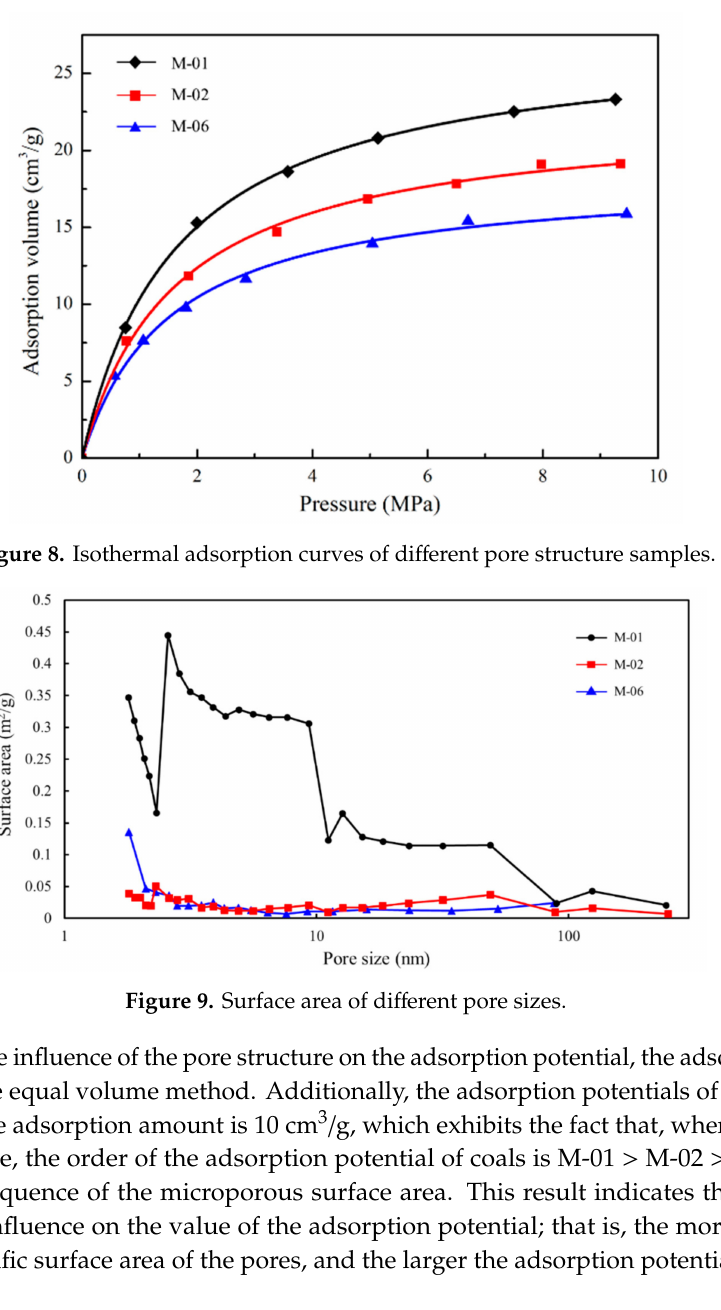
Table 3. Adsorption potential of di ff erent pore structure